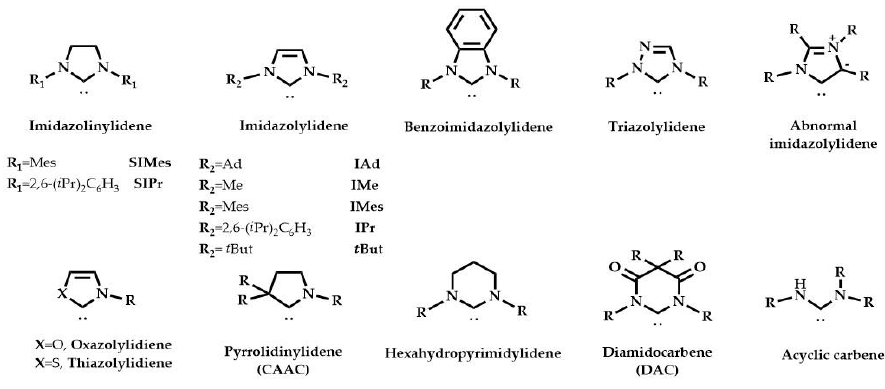
Figure 1. Structure of the most used NHC